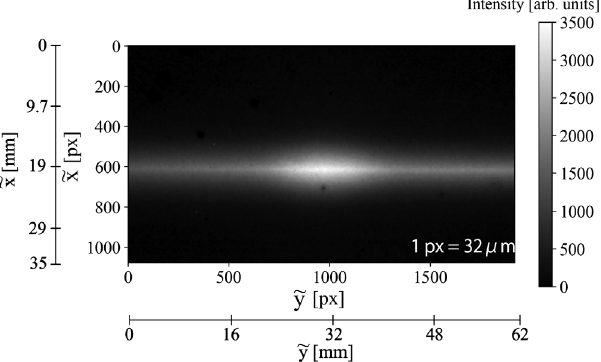
FIG. 12. An example of an image obtained by the gas sheet monitor. The white part is the photon signal. The geometry of the gas sheet and the H − beam is described in Fig. 7.